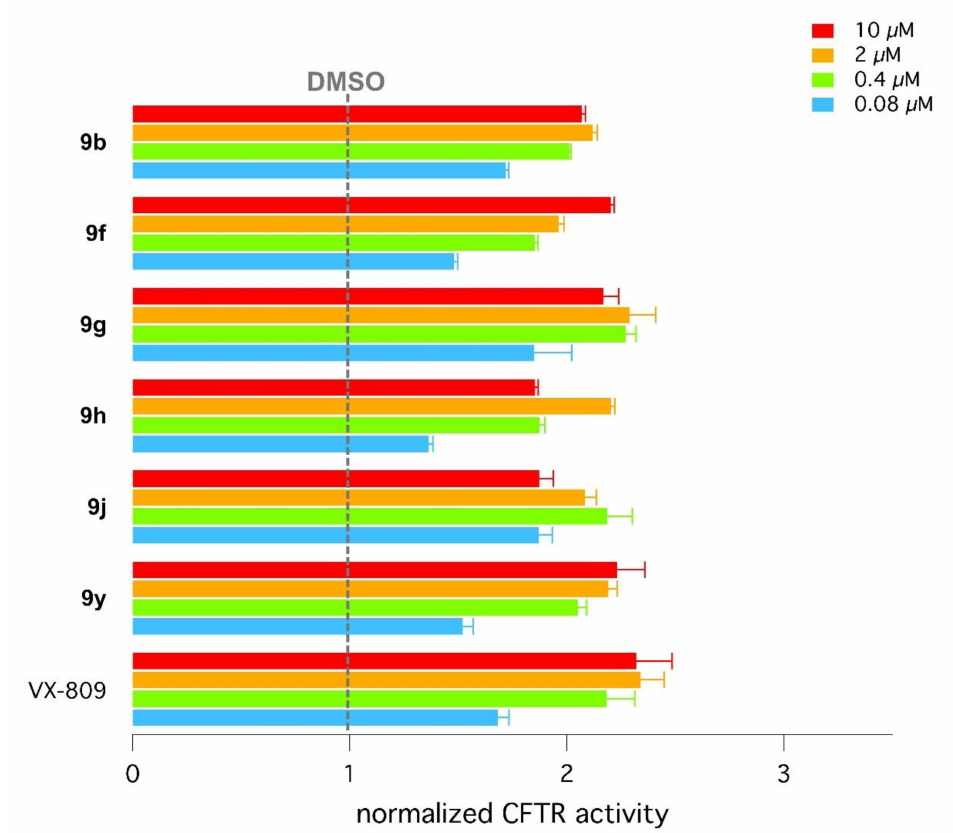
Figure 6. Efficacy of six active compounds on mutant CFTR rescue. The bar graph reports normalized F508del-CFTR activity, measured with the HS-YFP assay in F508del-CFTR-expressing CFBE41o-cells treated for 24 h with the indicated compounds at different concentrations. The dashed line indicates activity in cells treated with vehicle